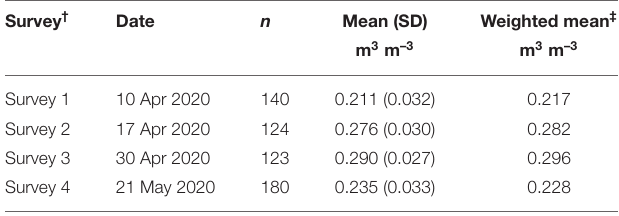
TABLE 1 | Summary of field soil moisture surveys in the top 12cm of the soil profile, including the number of observations ( n ), the mean, the standard deviation (SD), and the spatially-weighted